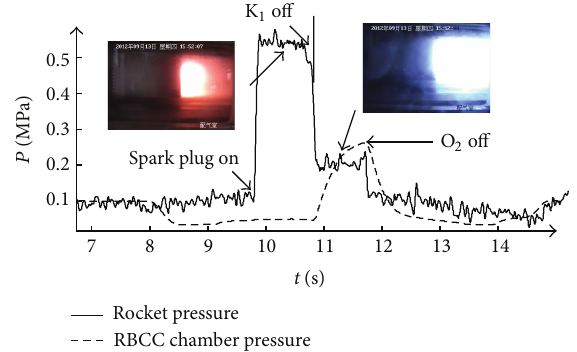
Figure 5: Pressure distribution under fuel/oxygen rich